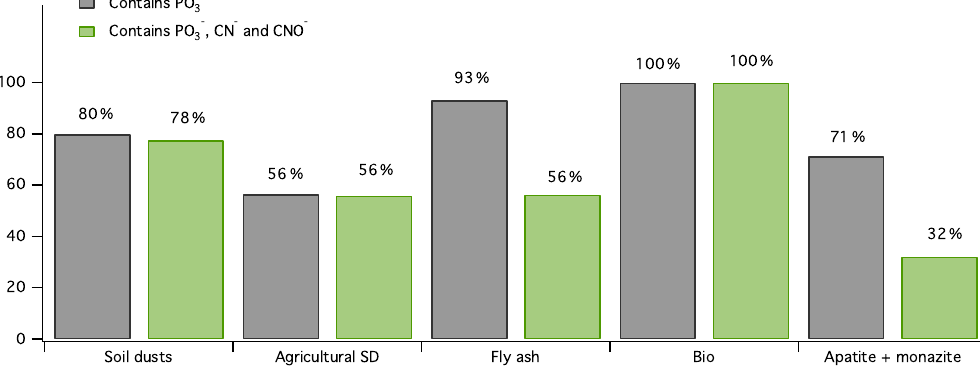
Figure 8. Percentage of particles that include PO − , CN − and CNO − markers in five classes of atmospherically relevant aerosol spectra 3 acquired with PALMS in this work. Note that the green bars indicate the percentage of particles of each type identified as biological using literature criteria. In the case of bioaerosol the identification is correct. In all other aerosol classes the green bar denotes a typical level of misidentification.